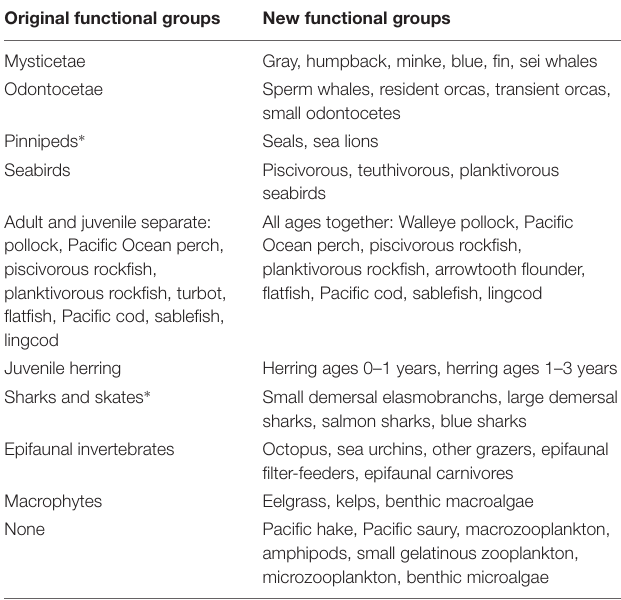
TABLE 1 | Modifications to functional group structure introduced in the present